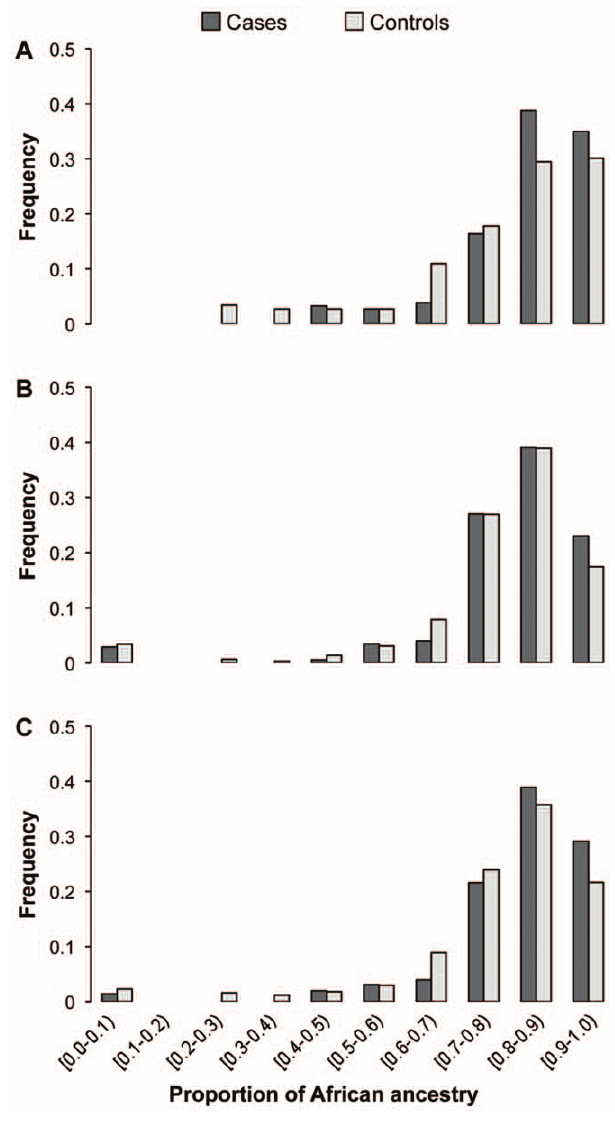
Figure 1. Histograms representing the proportion of individual African ancestry estimates based on 95 AIMs for REACH (A), BASS (B), and overall case-controls (C).